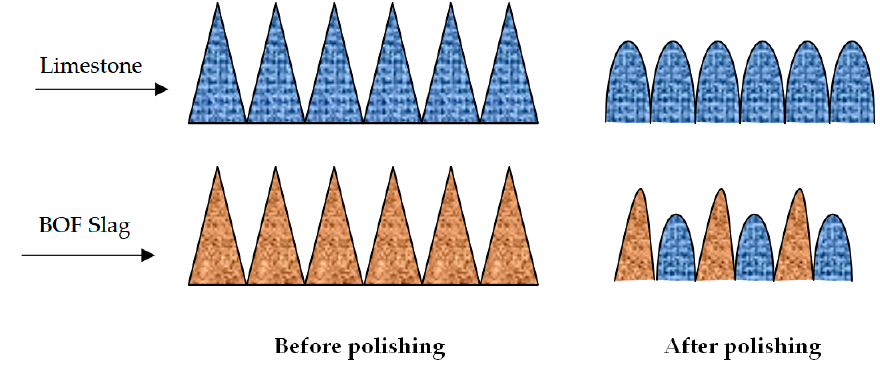
Figure 4. The contrast between general polishing and differential polishing.